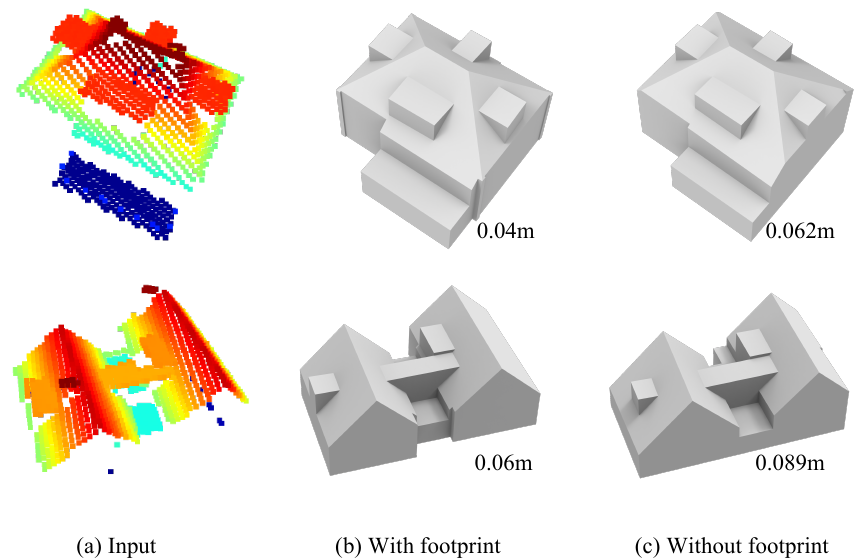
Figure 10. Comparison between the reconstruction with ( b ) and without ( c ) footprint data on two buildings ( a ) from the AHN3 dataset [21]. The number below each model denotes the root mean square error (RMSE). Using the inferred vertical planes slightly increases reconstruction errors.